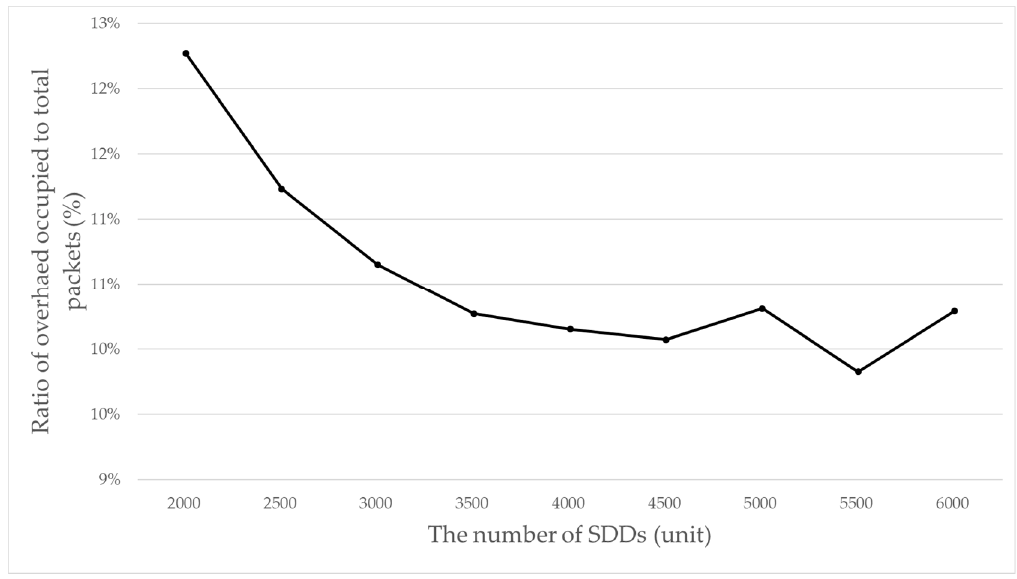
Figure 14. The ratio of the tree transformation overhead time to the total authentication time.